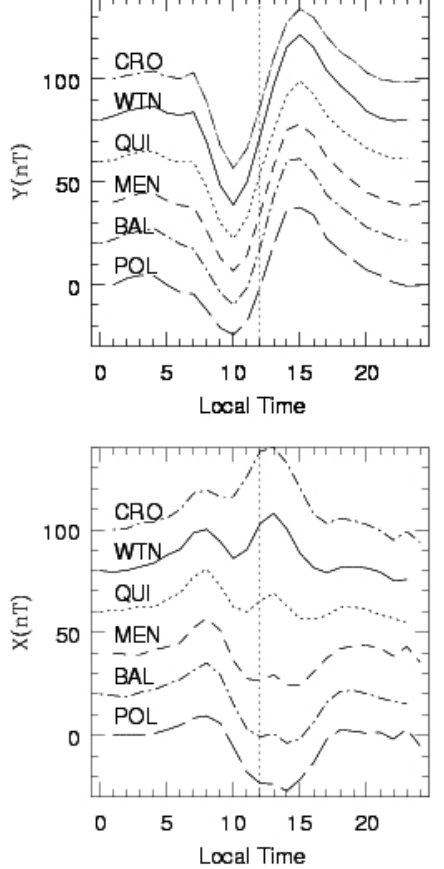
Fig. 6. Magnetic variations on 8 April 1990, plotted every half hour, as for Fig. 2. Fig 6. Magnetic variations on 8 April 1990, plotted every half hour, as for Fig 2.